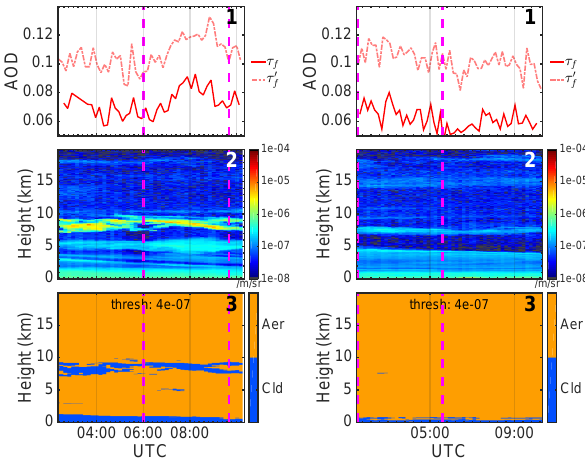
Figure 5. Zoom of the backscatter profile and the fine mode op- tical depths ( τ (cid:48) and τ f ) as a function of time on 9 March 2011 f (left) and 10 March 2011 (right). The 9 March case is the β thr = 4 × 10 − 7 m − 1 sr − 1 (right hand) case of Fig. 2a with a focus on fine mode optical depth variation. The purple dashed vertical lines show the approximate limits of where the plume (between 4 and 6km on 9 March and at around 8km on 10 March) is at its most optically active. Same pane description as in Fig.